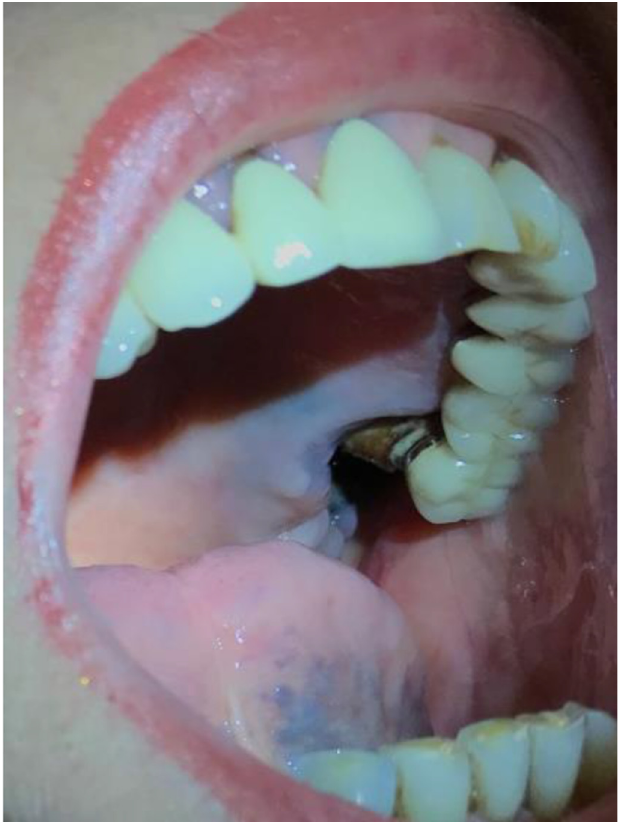
Fig. 3. Intraoral photography 3 weeks before initiating the radio- therapy, a diminution of the tumor volume can be